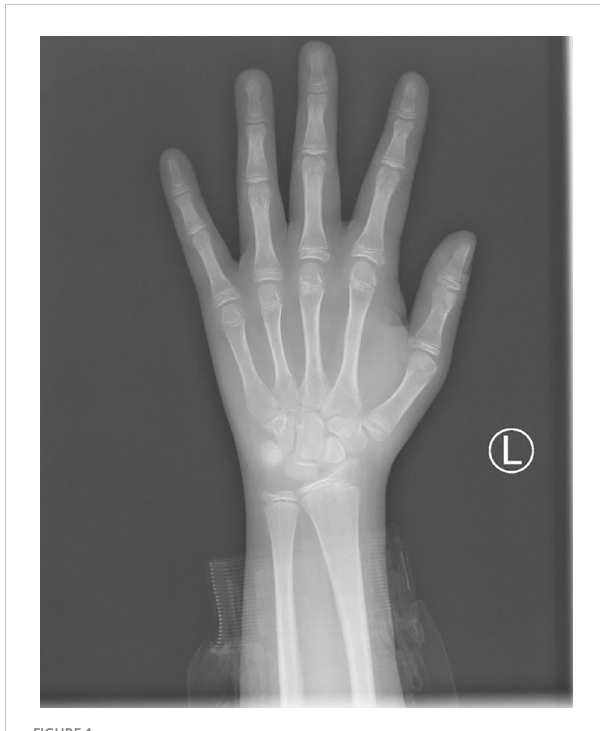
FIGURE 1 The bone age radiograph of the patient ’ s left